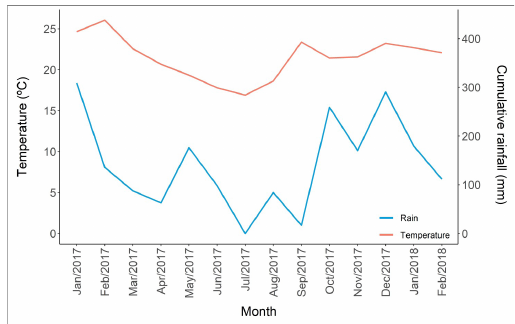
Figure 4. Accumulated monthly precipitation (mm) in the region of the marginal lagoon of the Tibagi River, Upper Paraná River Basin, municipality of Sertanópolis - PR, from January 2017 to February